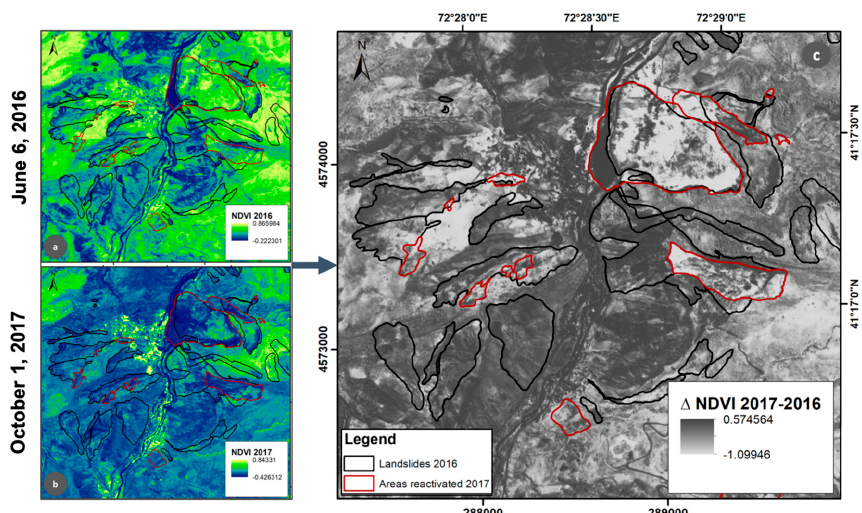
Figure 12. Difference of NDVI calculated for Pleiades images; ( a ) NDVI calculated for the Pleiades image of June 06, 2016; ( b ) NDVI calculated for the Pleiades image of October 01, 2017; ( c ) Difference of NDVI between 2017 and 2016. The limits of the 2016 landslides are outlined in black and the reactivated areas between the two acquisitions in red. The light areas (negative) represent significant land use changes and the dark gray areas (positive) indicate the fragments that remain almost unchanged (even with growing vegetation).